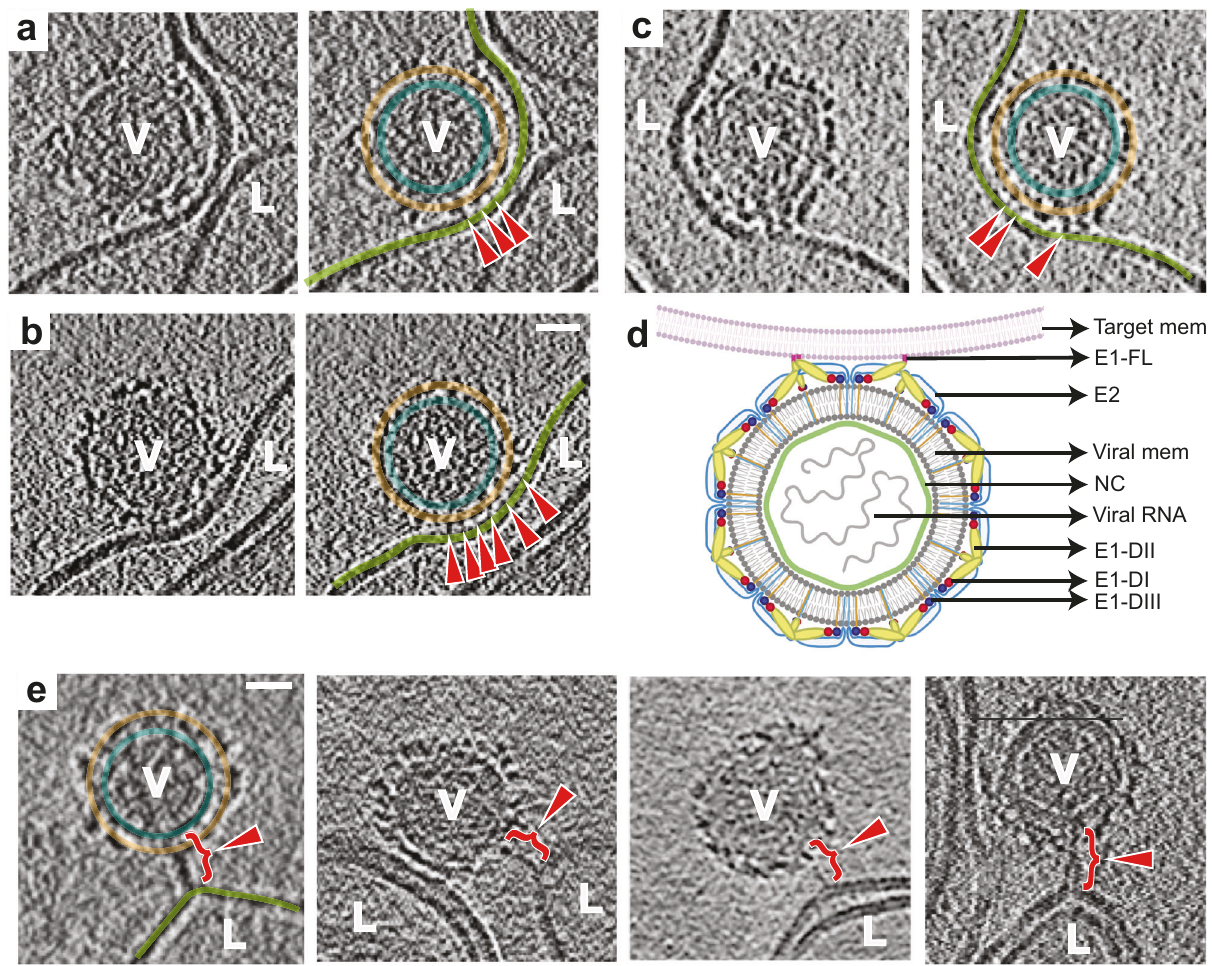
Fig. 2 | CHIKV membrane recruitment – stage I. a – c Left panel: Tomogram slice showing CHIKV (V) interacting with liposome (L) via thin, delicate attachments. Right:Sametomogramsliceasintheleftpanelbutannotatedtoshowthedifferent protein and membrane layers: CHIKV glycoprotein layer in orange, CHIKV mem- brane in teal and liposome membrane in green. The attachments between CHIKV andliposomemembranearedenotedbyredarrowheads. d Cartoonrepresentation